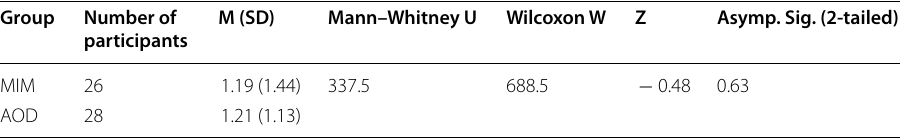
Table 1 Comparison of pre-class quiz scores between the two groups Group Number of participants